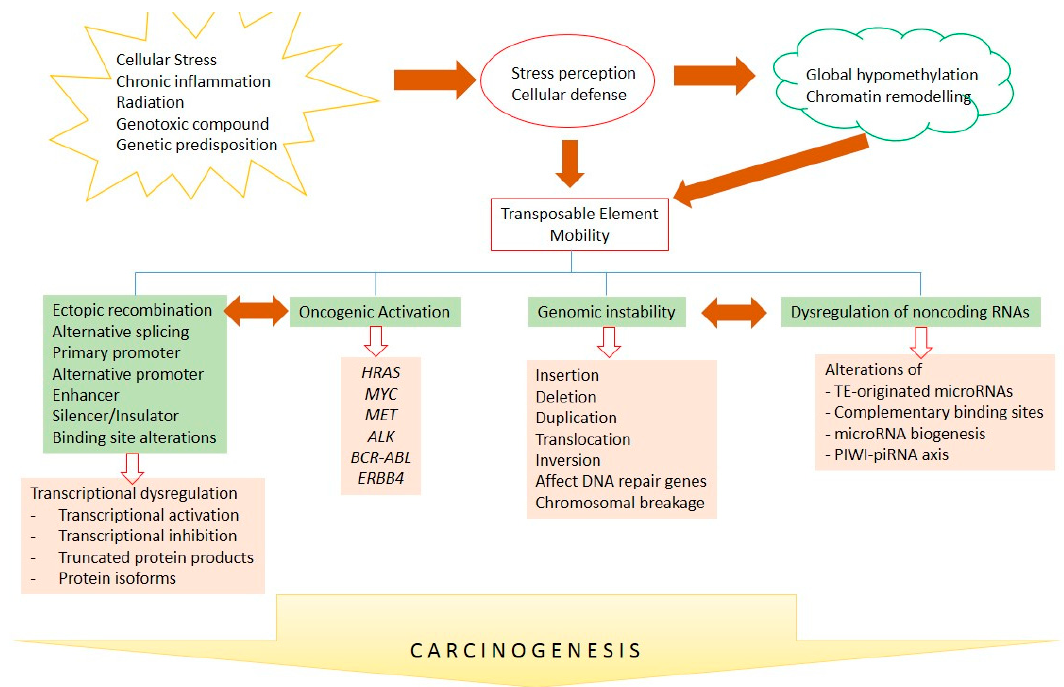
Figure 3. TE-mediated carcinogenesis. Intra- and extracellular-mediated stresses lead to TE mobility through alterations of DNA methylation and chromatin remodeling. TE mobility might further induce and interconnect transcriptional deregulation, the activation of oncogenes, genomic instability, and ncRNA deregulation, to further contribute to human carcinogenesis. Arrows show causality and bidirectional arrows represent inter-correlation.